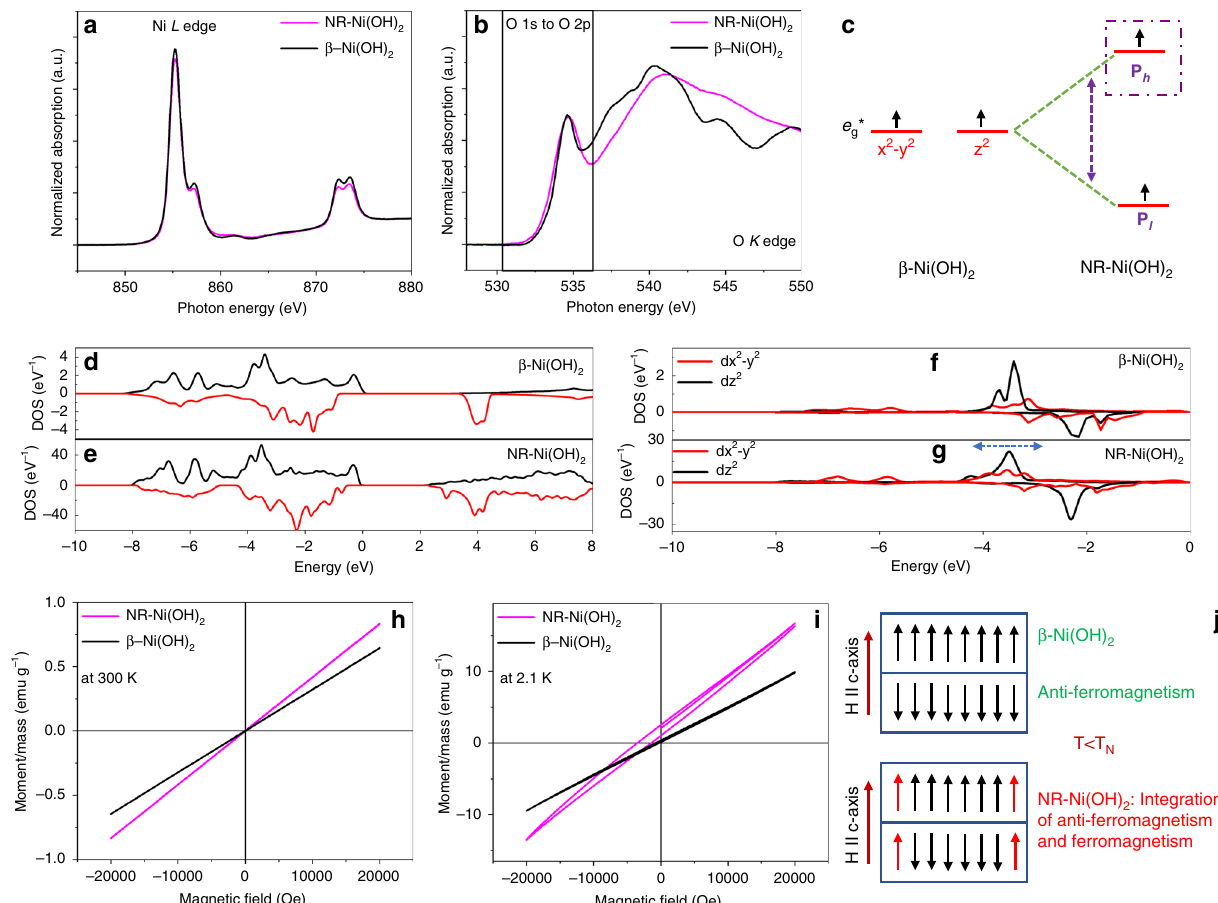
Fig. 3 Near-edge X-ray absorption fi ne structure and magnetic measurement. a Ni L edge spectra of β -Ni(OH) 2 and NR-Ni(OH) 2 ; b O K edge spectra of β -Ni(OH) e 2 and NR-Ni(OH) 2 ; c schematic of NR-Ni(OH) 2 g * orbital splitting; d , e projected density of states (PDOS) of respectively; f , g PDOS of e g * orbitals for β -Ni(OH) 2 and NR-Ni(OH) 2 , respectively; h M – H loops of β -Ni(OH) 2 and NR-Ni(OH) 2 at 300 K; i M – H loops of β -Ni(OH) β -Ni(OH) 2 and NR-Ni(OH) 2 at 2.1 K; j schematic of 2 and NR-Ni(OH) 2 magnetic